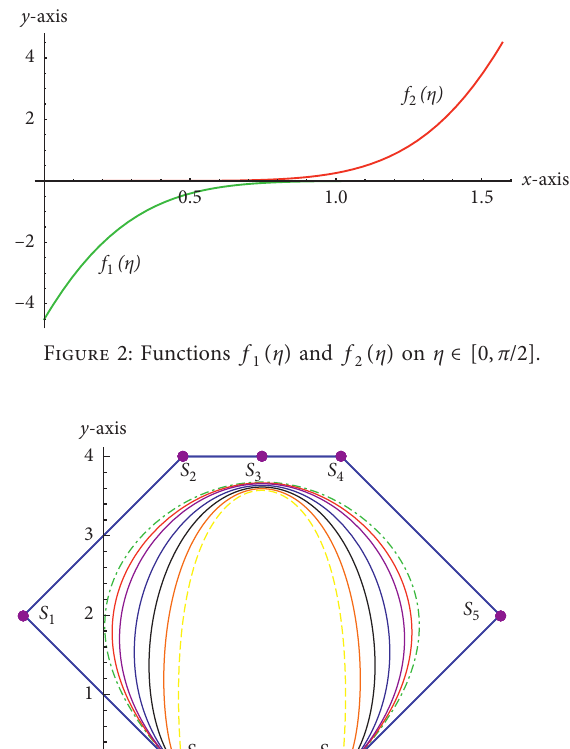
Figure 3: ST-B´ezier curves with some shape parameters when μ � ω � 1 , 0 . 5 , 0 , − 1 , − 2 , − 3 , − 4.